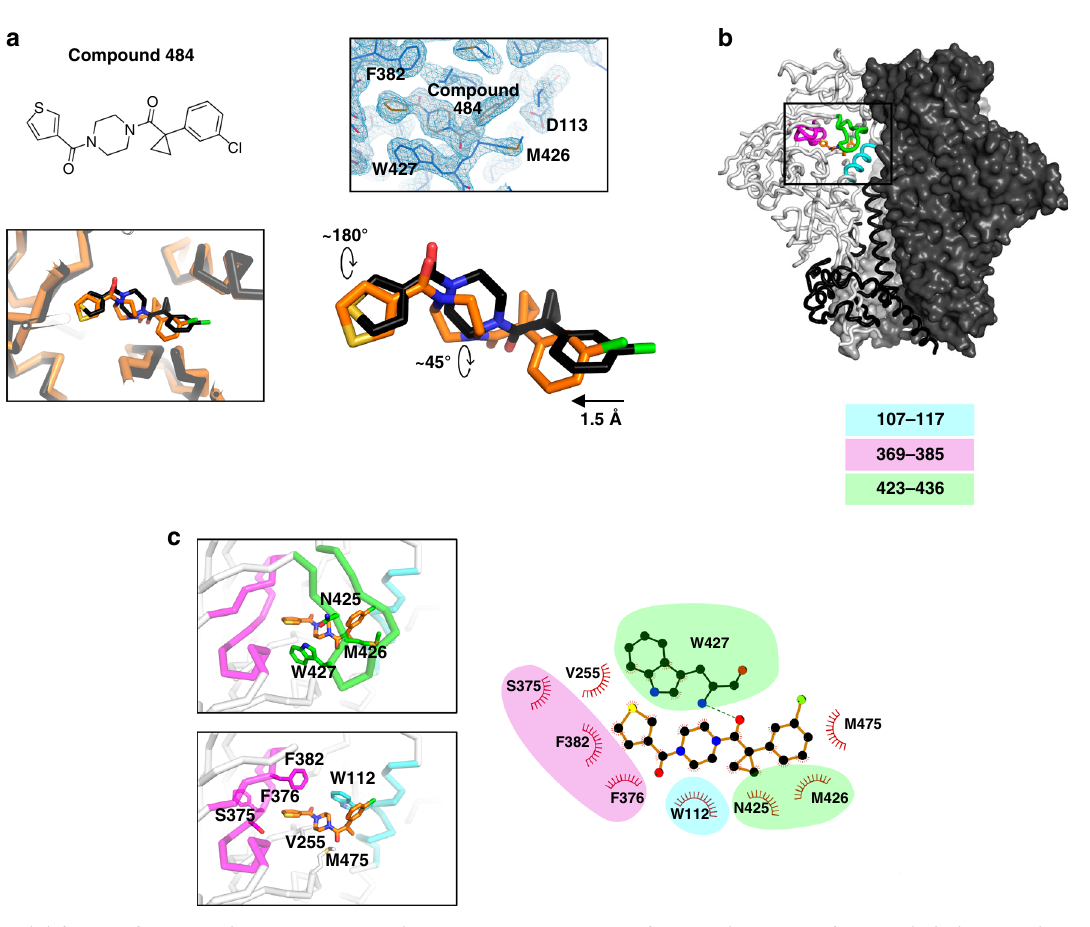
Fig. 3 Chemical de fi nition of compound 484 interaction with HIV-1 Env. a Comparison of cocrystal structure of 484 with docking simulation. The two structures are superimposed by the gp120 ( 484 not used for superimposition). Simulated 484 complex structure is colored in black and co-crystal structure colored in orange (lower left). 2Fo-Fc electron density showing the 484 binding pocket is contoured at 2 σ (top right). b Location of the entry inhibitor binding pocket in the context of HIV-1 Env trimer. The black square indicates the location of the inhibitor binding pocket. Three main protein segments interacting with the inhibitors are highlighted in cyan, magenta and green for residues 107 – 117, 369 – 385 and 423 – 436 respectively. c Detailed view of the 484 binding site. Upper panel on the left shows the residues of the β 20 − β 21 hairpin (green fragment) interacting with 484 . Lower panel on the left shows the all other residues interacting with 484 (excluding residues on the β 20 − β 21 hairpin, which is removed for clarity). Right, the 484 -Env interaction is shown as a 2D plot, with residues belonging to different major segments highlighted in different shades. Hydrophobic interactions are shown as sunray symbols while hydrophilic interactions are shown as dotted